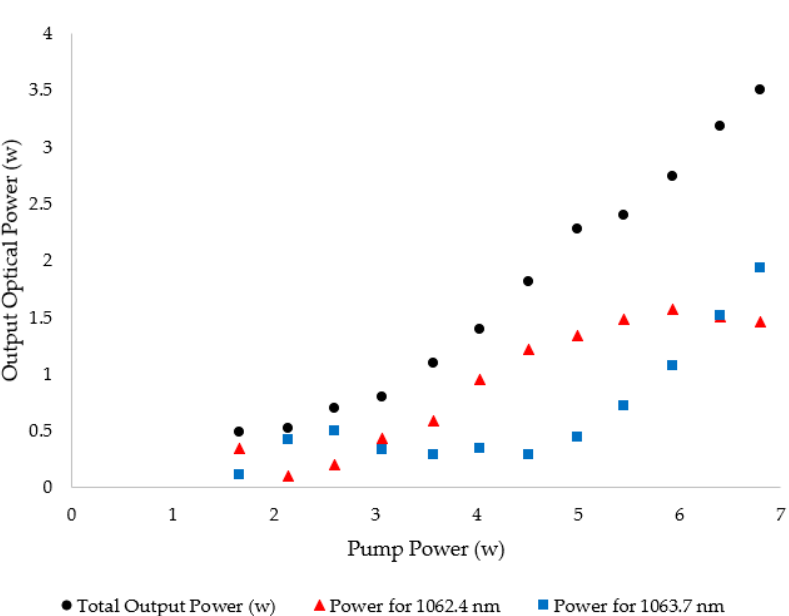
Figure 6 . The measured output power versus pump power for σ - π configuration, where the total output power, output power for 1062.4 nm, and 1063.7 nm are represented by black dots, red triangle up, and blue square, respectively.